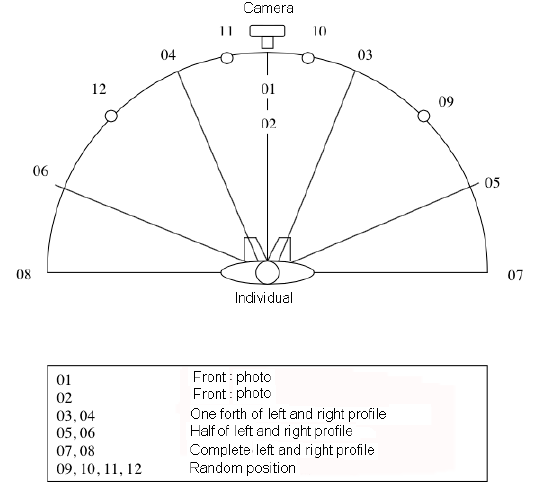
Figure 14. Camera Figure 14. Camera positions.